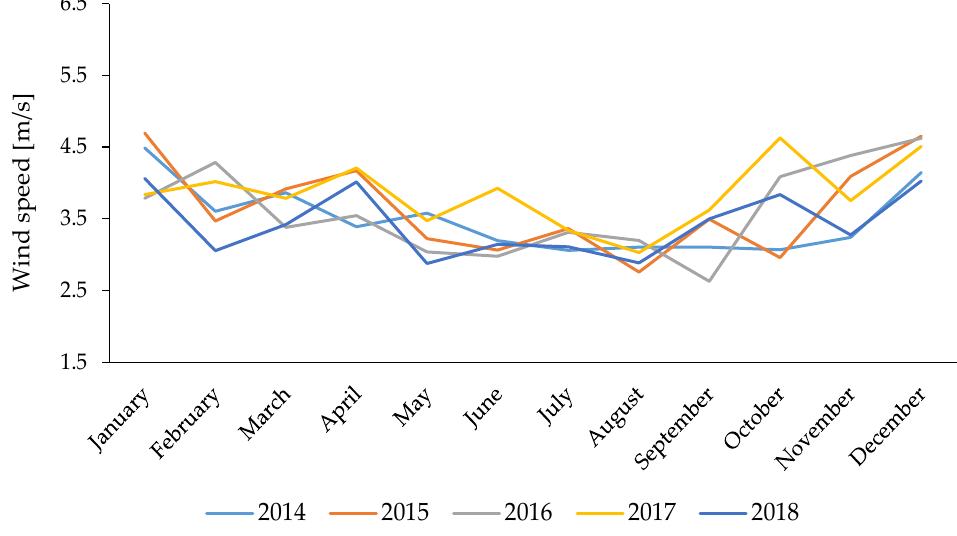
Figure 7. Distribution of average monthly wind speed among the three locations for the period 2014–2018.